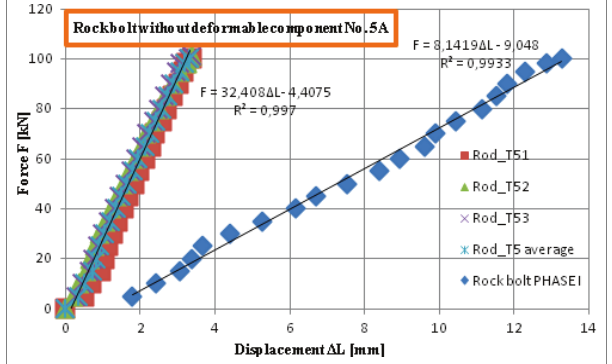
Fig. 38. The impact of the deformable